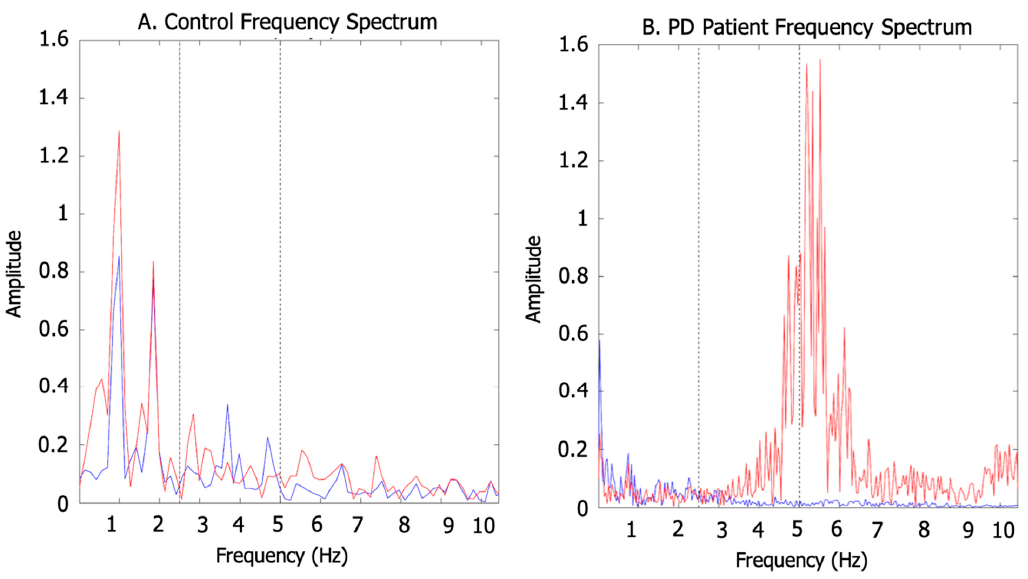
Figure 5. Examples of the spectral frequency for PD patients and controls. ( A ) Control frequency spectrum, step and strike peaks are in 1Hz and 2Hz, respectively. ( B ) Patient frequency spectrum, step and strike peaks are lower than tremor peak around 5H. (Red indicates the left arm, and blue indicates the right arm).